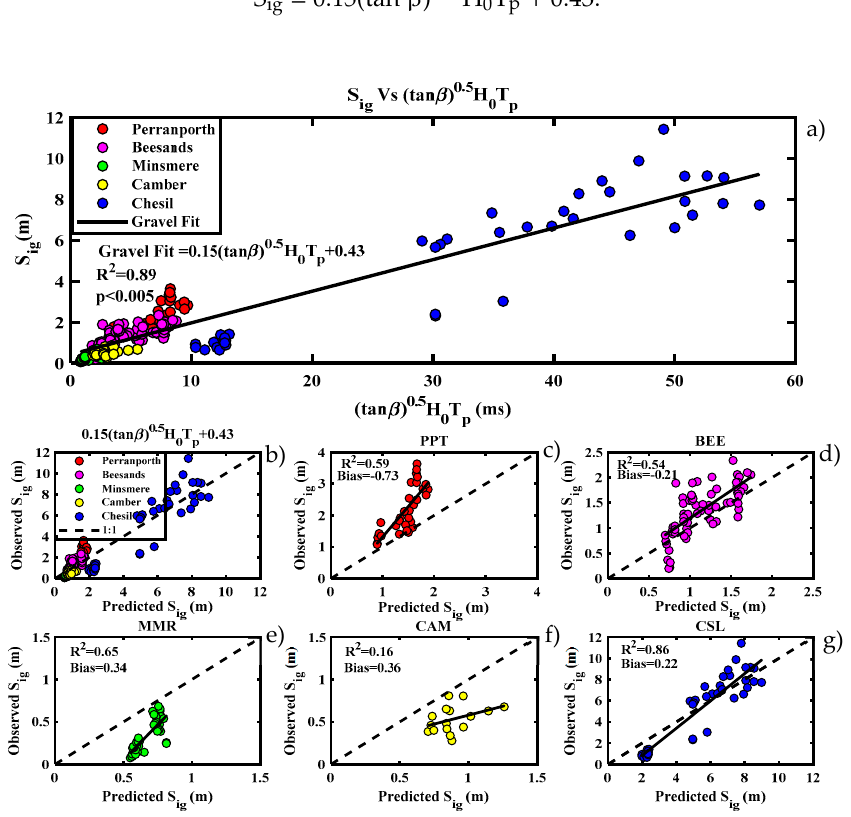
Figure 8. ( a ) Significant infragravity swash height S ig against (tan β ) 0.5 H 0 T p . Linear best fit for Beesands and Chesil (Equation (5)), black line. ( b ) Comparison of S ig heights observed and those predicted by Equation (5) at all sites. ( c – g ) As above, but for individual sites. Equation (5) has a y -axis intercept (c) of 0.43 resulting from the linear fit being extended beyond the lowest observed values of 0.15(tan β ) 0.5 H 0 T p . Given the positive intercept, Equation (5) should not be extended beyond the range of observed values of (tan β ) 0.5 H 0 T p and is, therefore, only applicable for values above 0.8 ms.